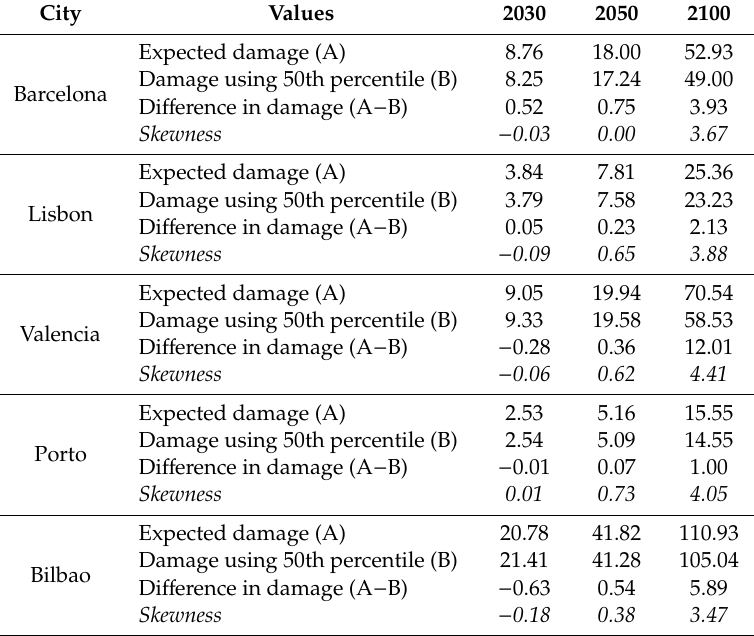
Table 2. Di ff erences in the six largest cities between expected annual damage and damage using the 50th percentile under RCP 8.5. The skewness of the sea-level rise distribution is also presented for each city.